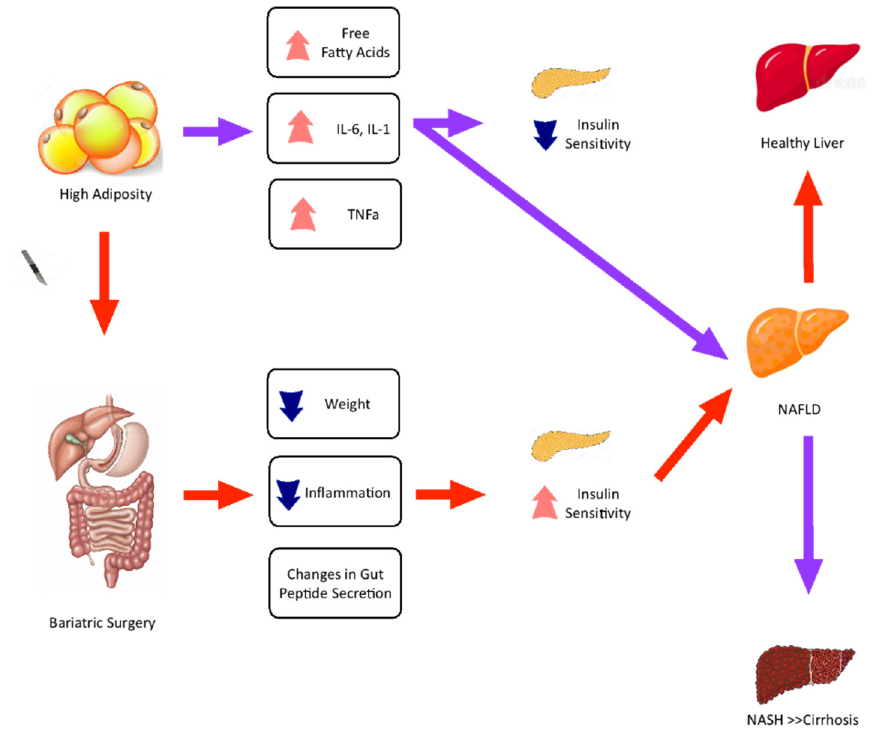
Figure 1. Mechanisms of protection and development of non-alcoholic fatty liver disease (NAFLD) in people living with obesity.